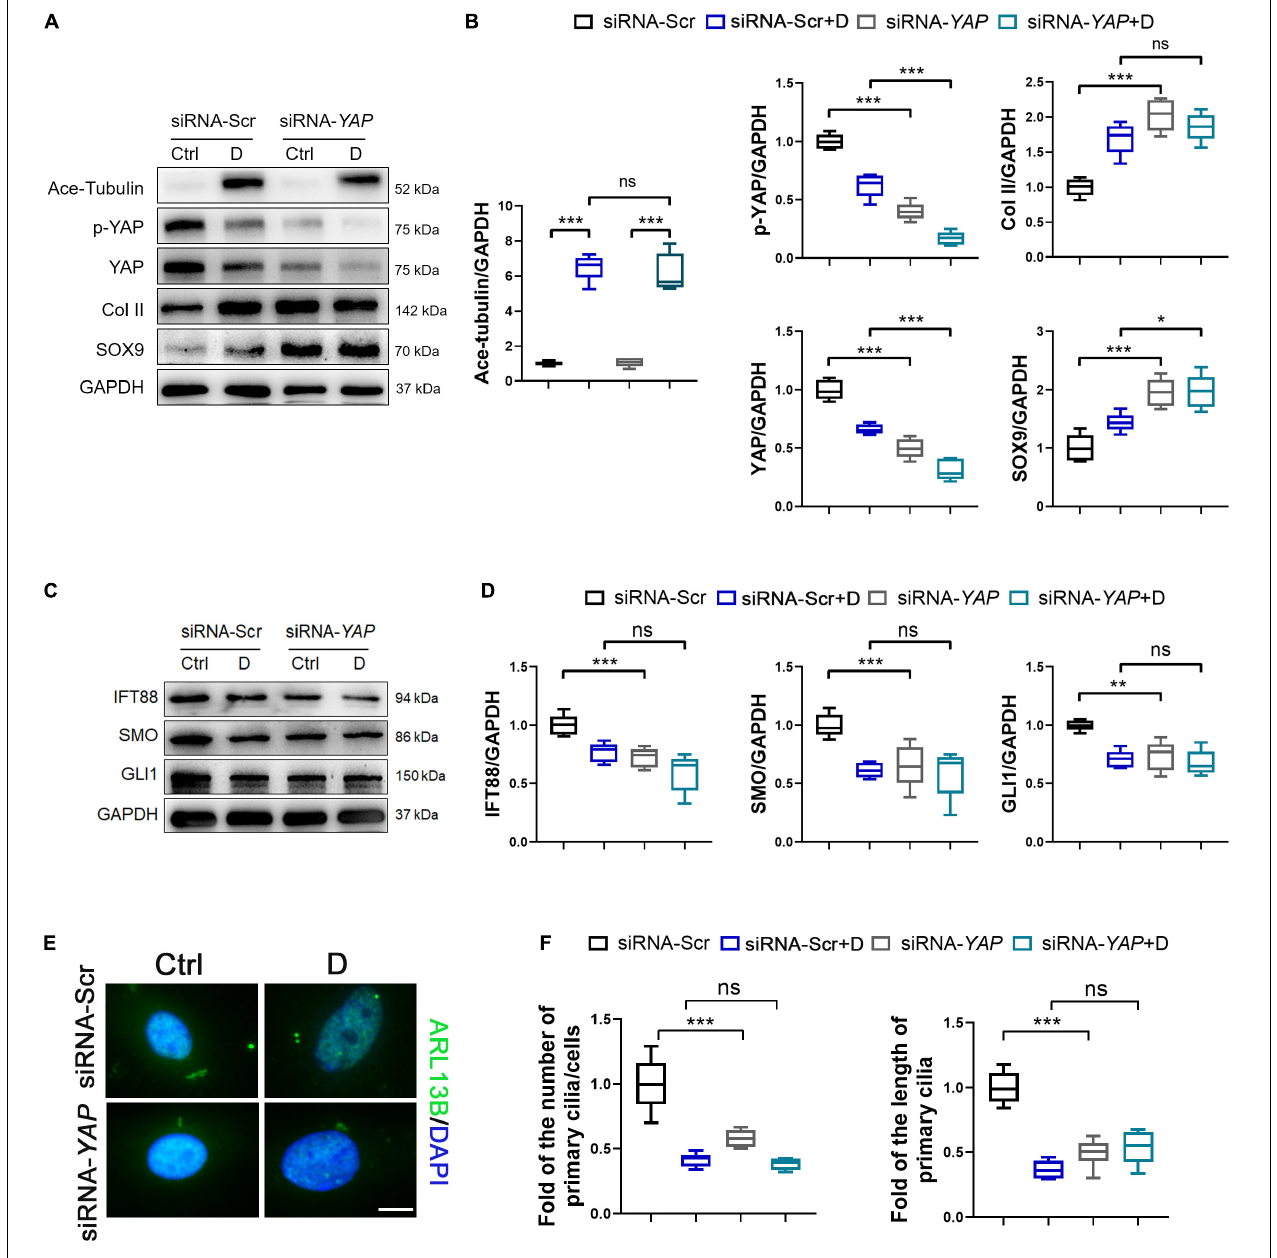
FIGURE 5 | Knockdown of YAP promotes chondrogenesis and inhibits primary cilia formation in SMSCs. (A) Western blot analysis of Ace-Tubulin, phosphorylated Yes-associated protein (YAP), YAP, Col II, and SOX9 in synovial mesenchymal stem cells (SMSCs) transfected with siRNA-YAP and treated with docetaxel (D) for 1 week. (B) Quantification of the data of (A) . n = 5. (C) Western blot analysis of IFT88, SMO, and GLI1 in SMSCs transfected with siRNA-YAP and treated with docetaxel (D) for 1 week. (D) Quantification of the data of (C) . n = 5. (E) Immunofluorescence staining for ARL13B in SMSCs. (F) Quantification of (E) for the number and length of primary cilia in SMSCs. n = 5. Data are represented as the mean ± SEM. * p < 0.05, ** p < 0.01, *** p <